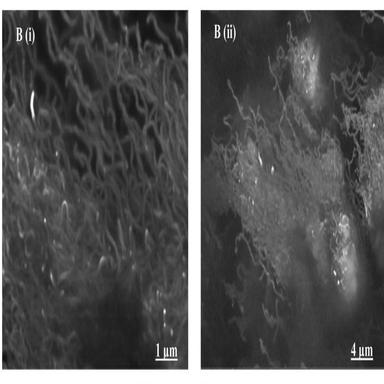
SEM images of 3% dispersion of paraffin wax and MWCNTs with various scale: B (i) treated MWCNTs with 1 µm, B (ii) treated MWCNTs with 4 µm, B (iii) treated MWCNTs with 10 µm.